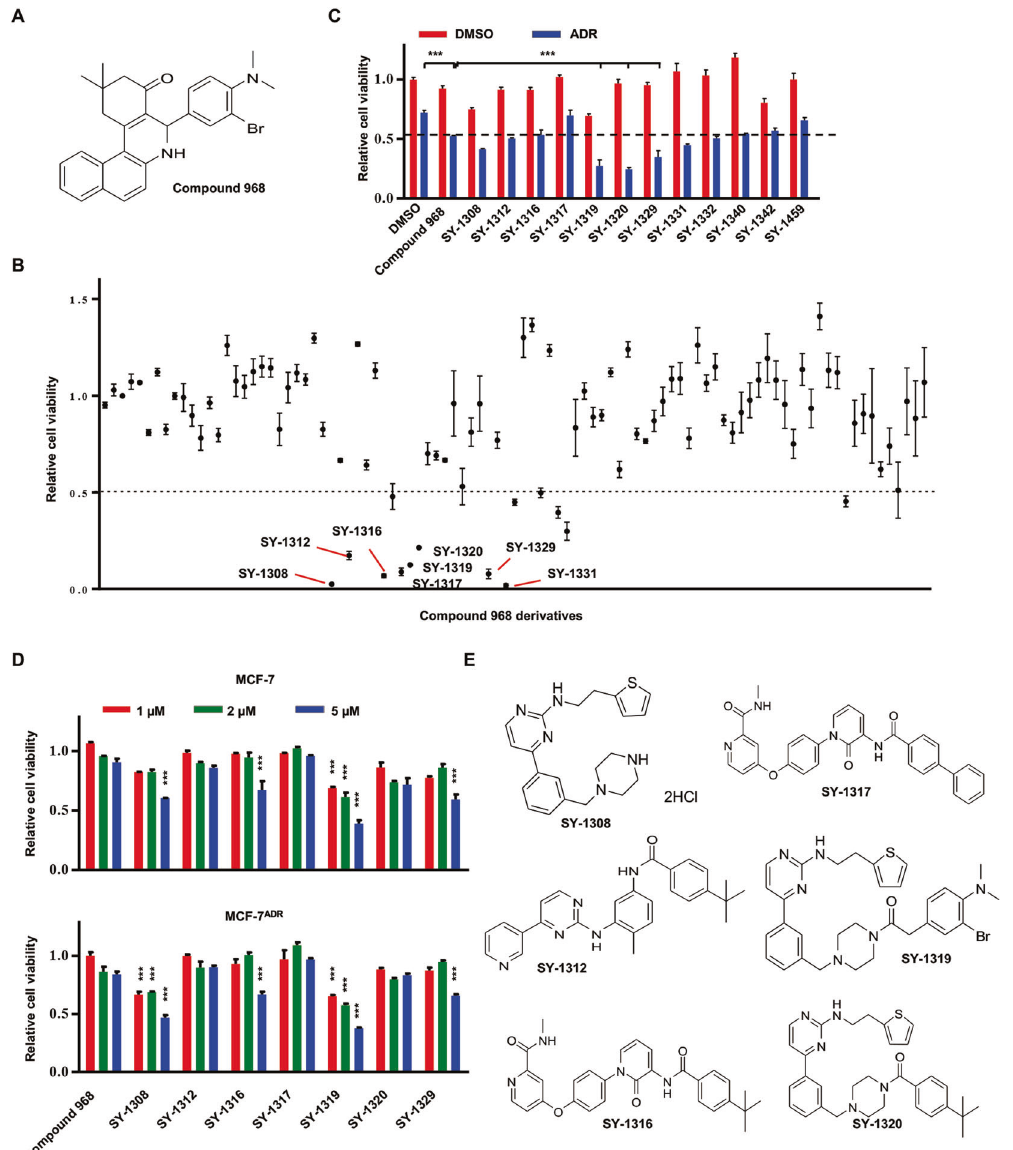
Fig. 2 Compound 968 analogs exert synergistic inhibitory effects with ADR against MCF-7 ADR cell viability. A Chemical structure of compound 968. B Ninety- fi ve analogs of compound 968 were synthesized and tested. MCF-7 ADR cells were treated with compound 968 analogs (10 µM) combined with ADR (2 µM) for 48 h. Cell viability was detected using the CCK8 assays. C MCF-7 ADR cells were treated with compound 968 or compound 968 analogs alone (2 µM), together with ADR (2 µM) for 48 h. Cell viability was detected using the CCK8 assays. D MCF-7 and MCF-7 ADR cells were treated with compound 968 or compound 968 analogs (0, 1, 2, and 5 µM) for 48 h. Cell viability was detected using the CCK8 assays. All groups were compared with the compound 968-treated group. E Chemical structures of compound 968 analogs. Data are presented as mean ± SD of three independent experiments. *** P < 0.001, two-tailed Student ’ s t